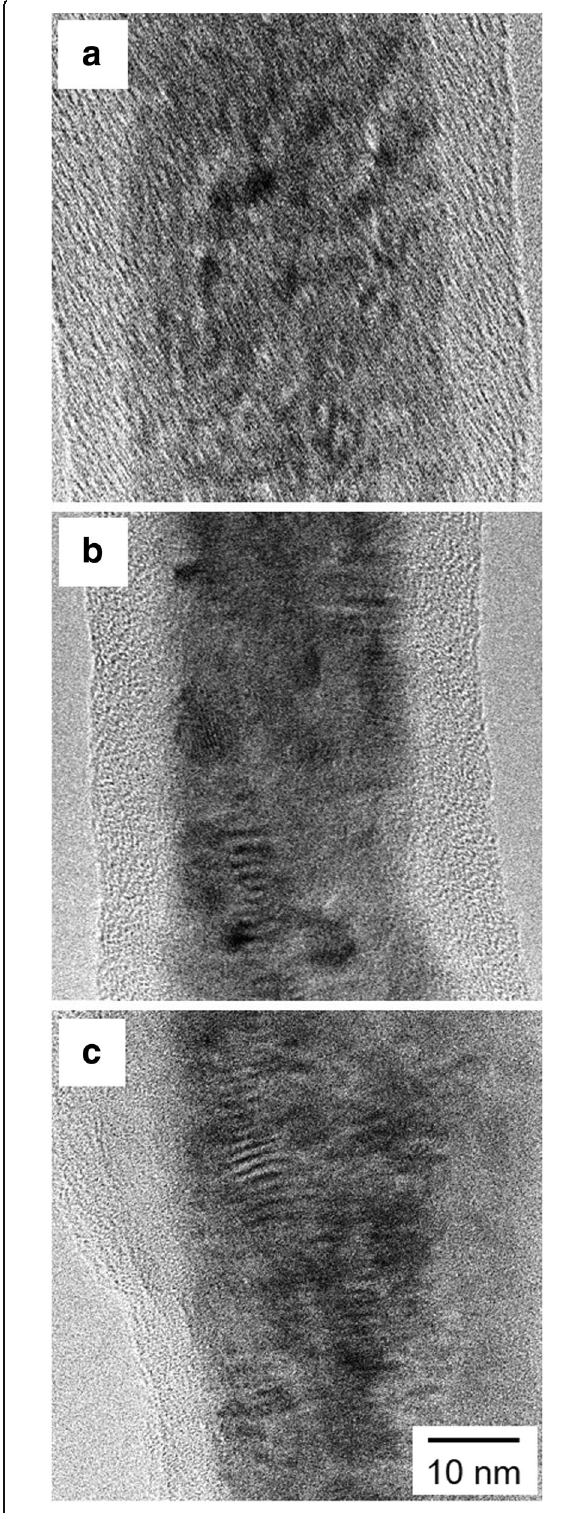
Fig. 6 TEM bright-field images of Fe nanowires separated from a AAO membrane. a Potentiostatic deposition at − 1.2 V, b pulsed potential deposition with the on-time potential of − 1.5 V, and